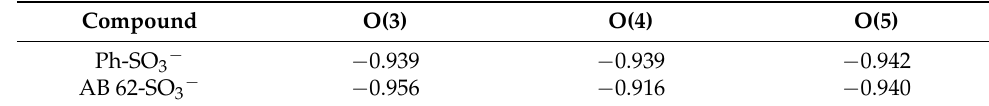
Table 8. The summary data of electron densities of oxygen atoms in the sufo group of benzenesulfonic acid and AB 62.